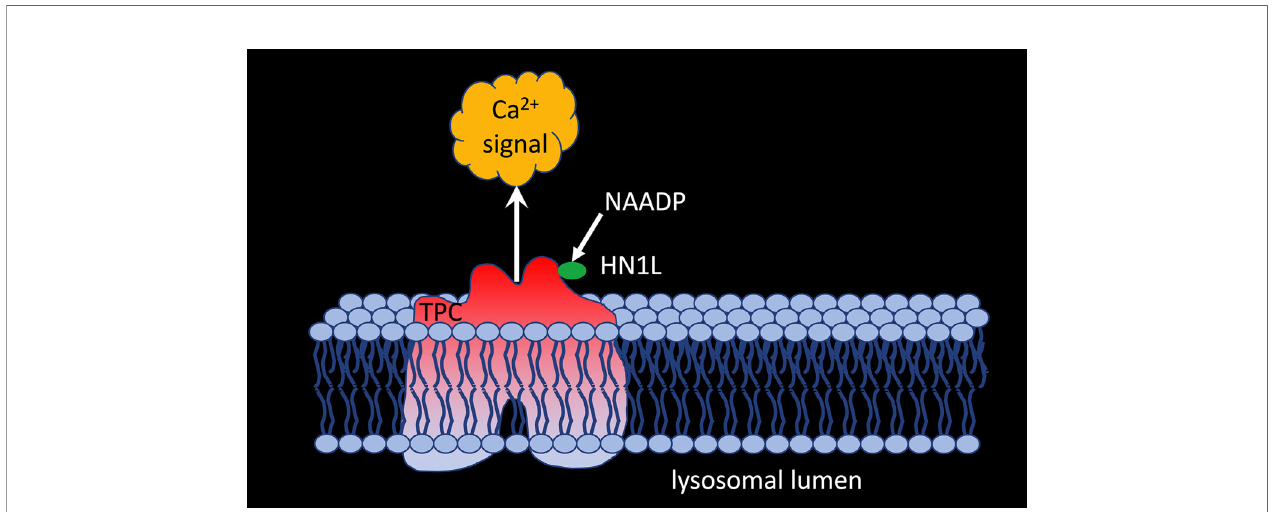
FIGURE 2 | HNL1/JPT2 interacts with TPC1 and is essential for NAADP-evoked calcium signaling via two pore